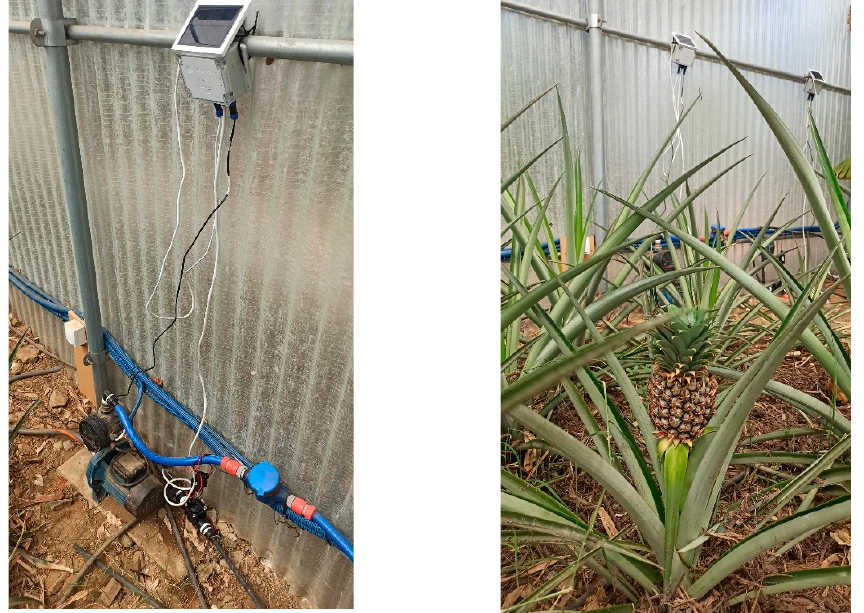
Figure 21. IoT nodes for automating the irrigation in the greenhouse.